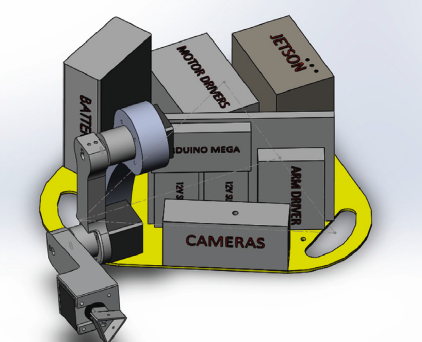
Figure 3: Populated mobile Bbse. The manipulator used is a Brunel Hand 2.0, an open-source robotic end-effector. The manipulator and its built-in controller are shown in Figure